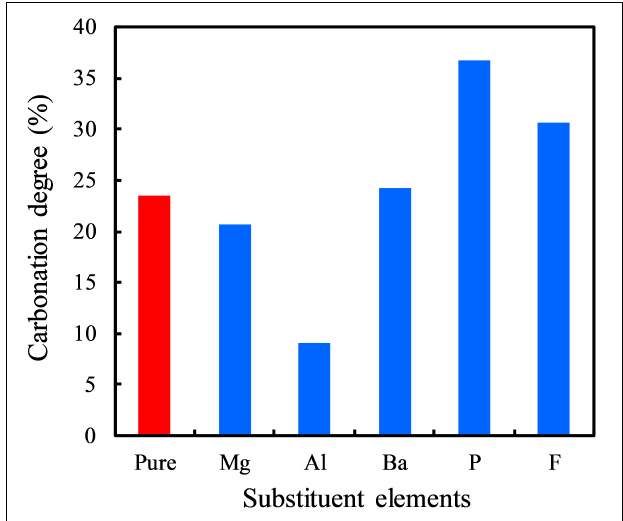
FIGURE 7 | Carbonation degree of γ -Ca 2 SiO 4 specimens in 3 days under normal pressure with different doping